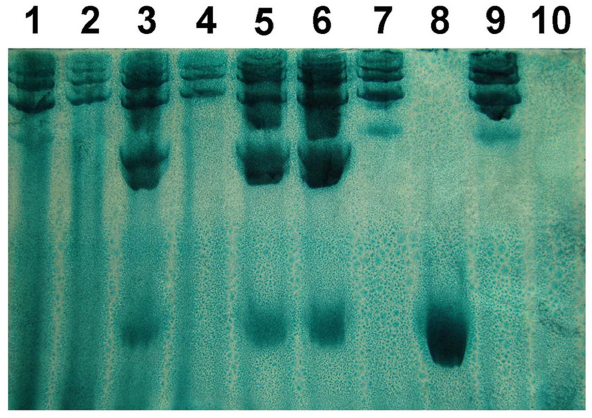
Figure 5. Representative patterns of Hp phenotypes after polyacrylamide gel electrophoresis of hemoglobin-enriched serum. Bands correspond to Hp-hemoglobin complexes. Hp1-1 shows a single migrating band. Hp2-2 has a series of more slowly migrating bands. Hp2-1 displays another series of more slowly migrating bands and a weak band that migrates similar to the Hp1-1 band. Hp1-1: lane 8; Hp2-1: lanes 3, 5 and 6; Hp2-2: lanes 1, 2, 4, 7 and 9; Hp0: lane 10. doi:10.1371/journal.pone.0095345.g005 PLOS ONE |